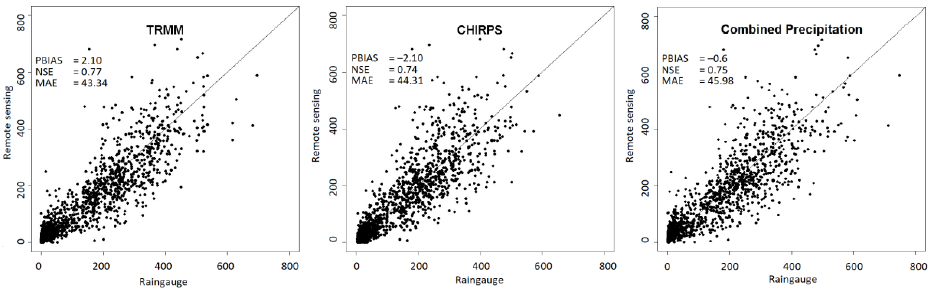
Figure 3. Performance of precipitation products Tropical Rainfall Measuring Mission (TRMM), Climate Hazards Group InfraRed Precipitation with Station (CHIRPS), and the Combined Precipitation against field measurements. Remotely sensed precipitation (mm) is displayed in the vertical axes while the horizontal axes show in situ measurement.